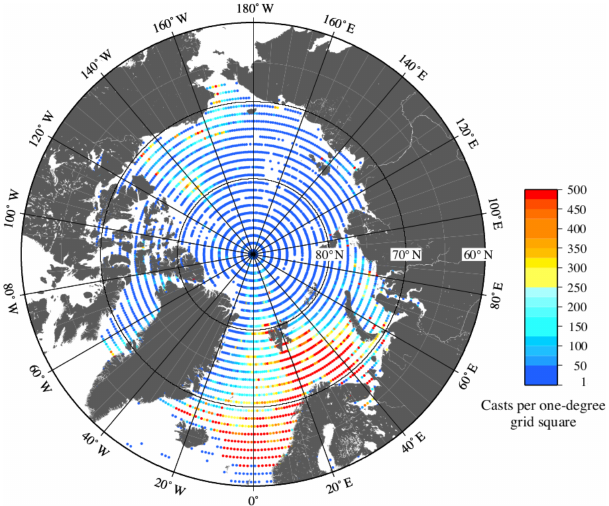
Figure 2. Data density of Arctic Ocean casts in WOD13. Areas left white indicate no data. Please note that the area of the 1 ◦ grid squares become increasingly small as they approach the